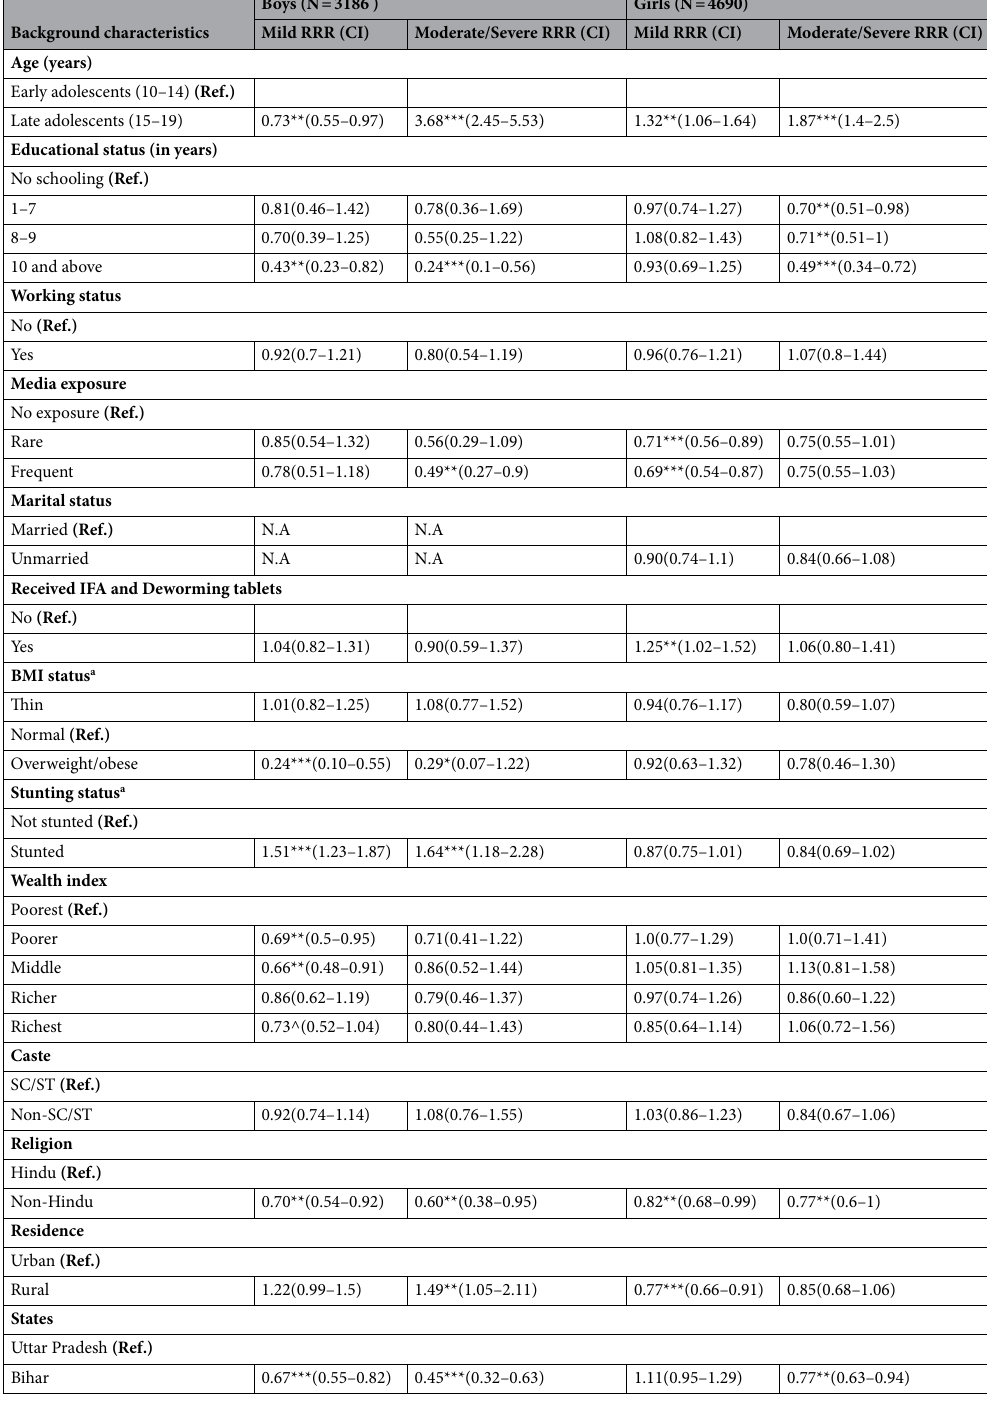
Table 3. Relative risk ratios (RRRs) obtained from multinomial logistic regression of anaemia among adolescents by background characteristics, India. RRR = Relative risk ratio; CI = Confidence interval;